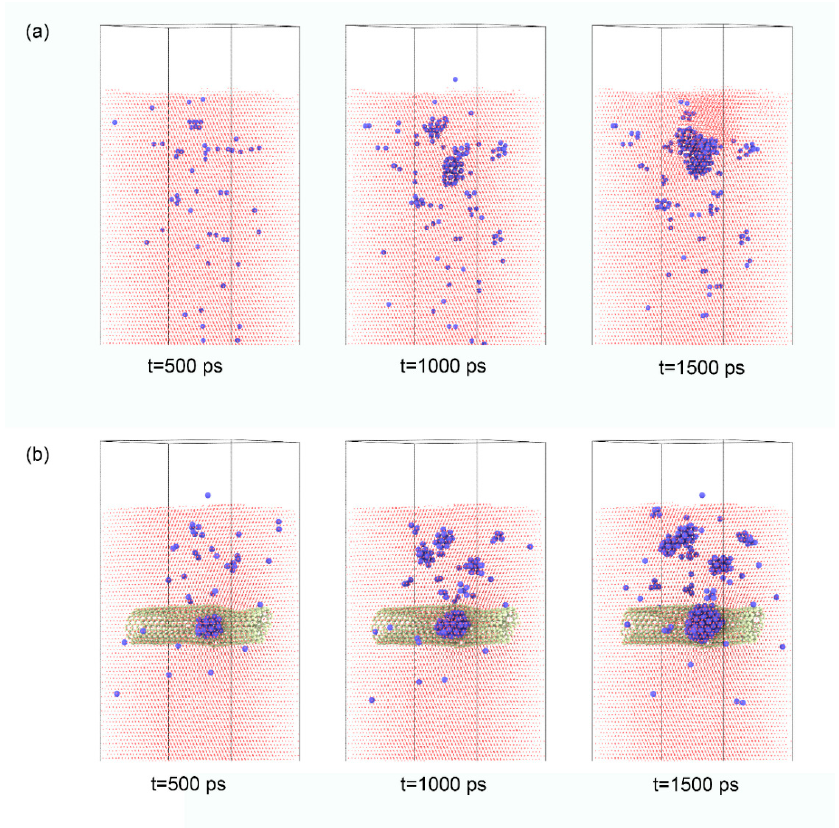
Figure 2. He clusters in the matrix when the incident energy of the He atoms was 300 eV. ( a ) Fe matrix; ( b ) SWCNT/Fe composite. The blue and yellow balls denote He and C atoms, respectively.